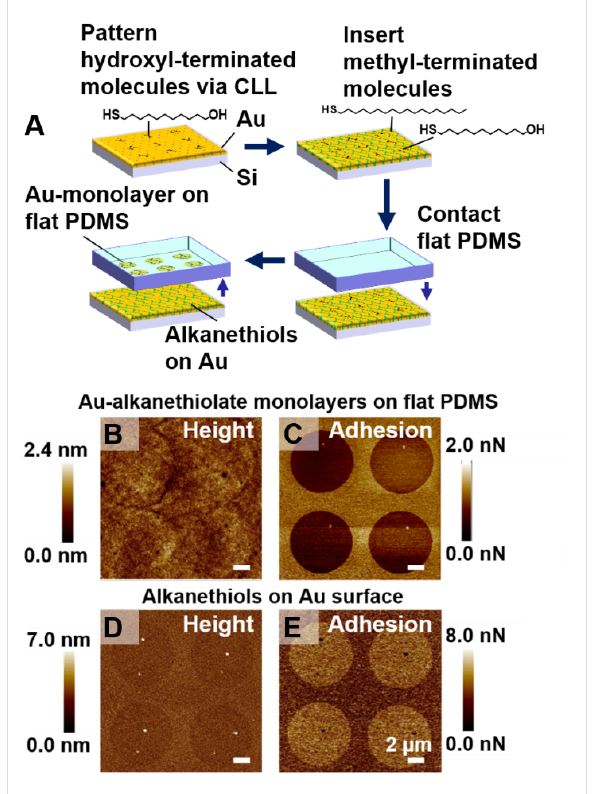
Figure 3: Chemically selective lift-off onto a flat poly(dimethylsiloxane) (PDMS) sample. (A) First, chemical lift-off lithography (CLL) was per- formed with a stamp having recessed circular features and a preformed self-assembled monolayer of mercaptoundecanol. Methyl- terminated alkanethiol molecules were then inserted into the contact regions, resulting in a self-assembled monolayer with patterned termi- nal functionalities. Performing a second round of CLL using this sub- strate and flat PDMS sample resulted in lift-off of the Au–alkane- thiolate monolayer from regions containing hydroxyl-terminated mole- cules. (B) Height and (C) adhesion maps of the Au–alkanethiolate fea- tures on PDMS. These maps were simultaneously acquired using peak-force atomic force microscopy. (D) Height and (E) adhesion maps of the remaining alkanethiols on Au after CLL. The topography and adhesion maps in panels B and C show inverted contrast from those in panels D and E,